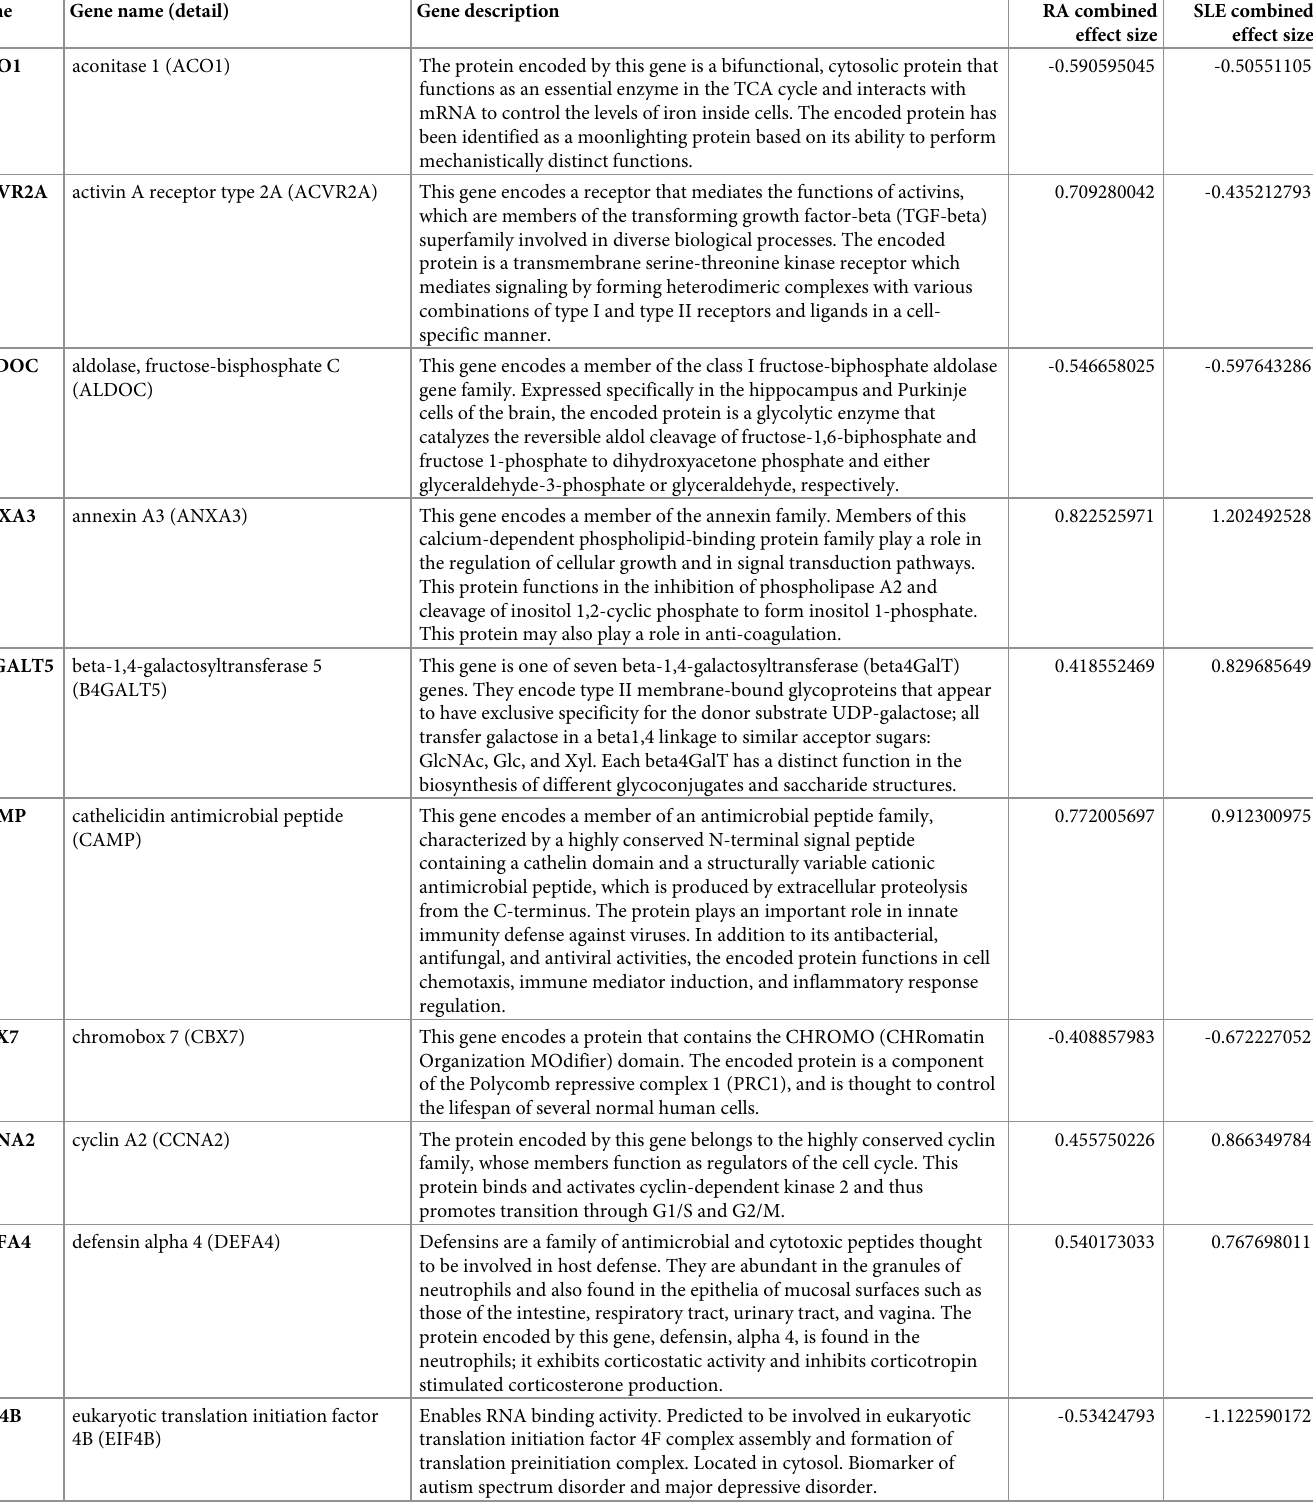
Table 2. Detailed description of the common gene signatures persistent across both diseases, and cell types.